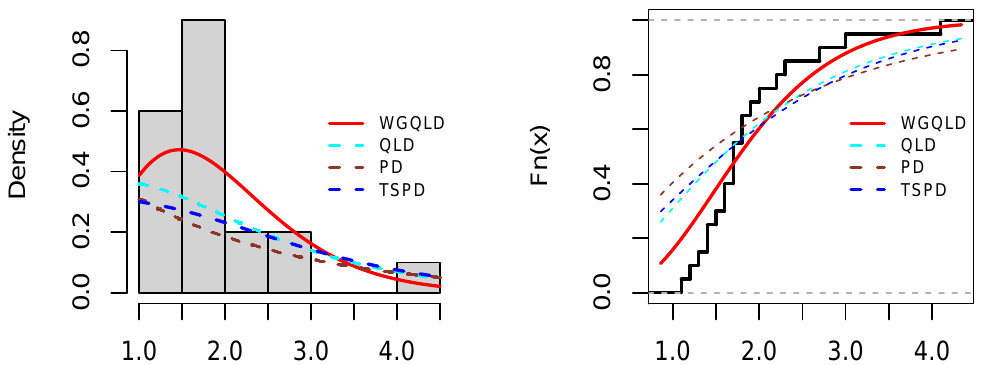
Figure 3. Plots of estimated probability density functions and cumulative distribution functions for patient data.